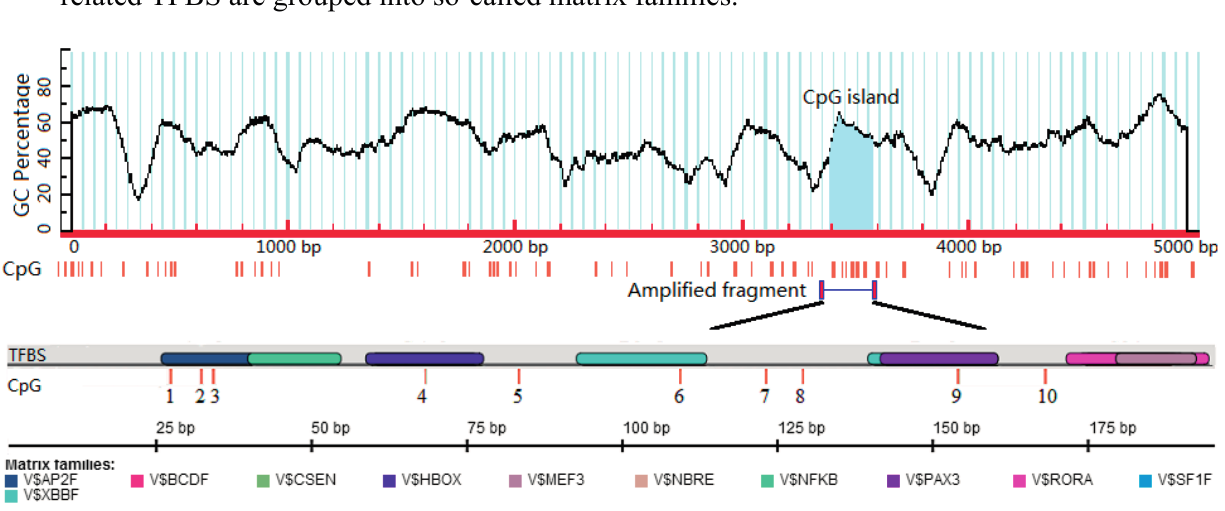
Figure 1. Bioinformatic analysis of the CpG island of the porcine BPI gene upstream-5kb region. TFBS: transcription factor binding sites; Matrix Families: similar and/or functionally related TFBS are grouped into so-called matrix families.